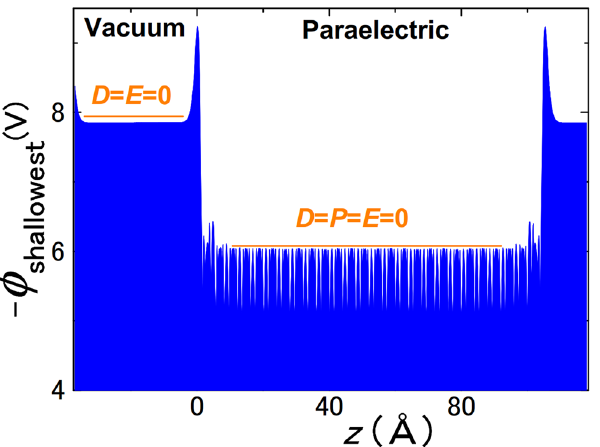
Figure 7. Ab initio electrostatic potential of paraelectric insulating BTO in vacuum showing peaks due to surface dipoles formed by electron smear-out and buckling. In this calculation of 26.5 unit-cell-BTO slab, all the ϕ ion positions are fully relaxed, and the insulting paraelectric state is the lowest energy state. = 0 in FE means E d = 0, for which Eq. (2) suggests P S = 0. P S = 0 is also directly confirmed by ab initio calculations. Similarly, E d = 0 ϕ in vacuum. Therefore, D = 0 in FE and